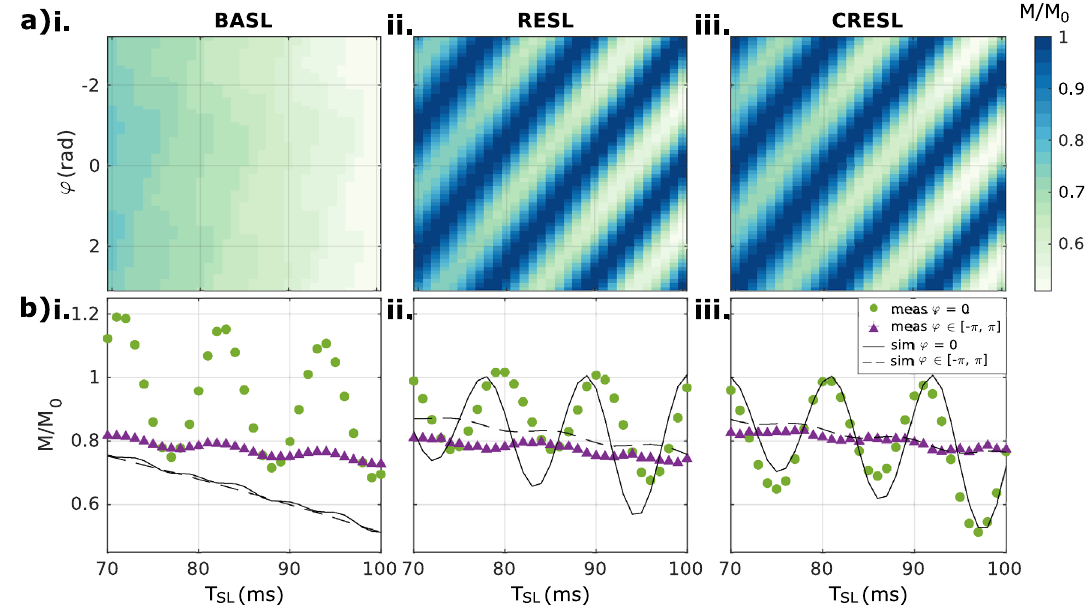
Figure 3. SIRS contrast dependence with phase. ( a ) Simulated contrast amplitude as a function of T SL and the initial phase of the target oscillating field ϕ for a sinusoidal field in resonance with the SL pulse for (i) BASL, (ii) RESL and (iii) CRESL. ( b ) Measurement and simulation of the contrast in resonance condition as a function of T SL for the cases of triggered ( ϕ = 0 , circles and plain lines) and averaged non-triggered signal (random initial phase, triangles, and dashed lines). B NC = 75 nT, ω NC = ω SL = 2 π 90 Hz